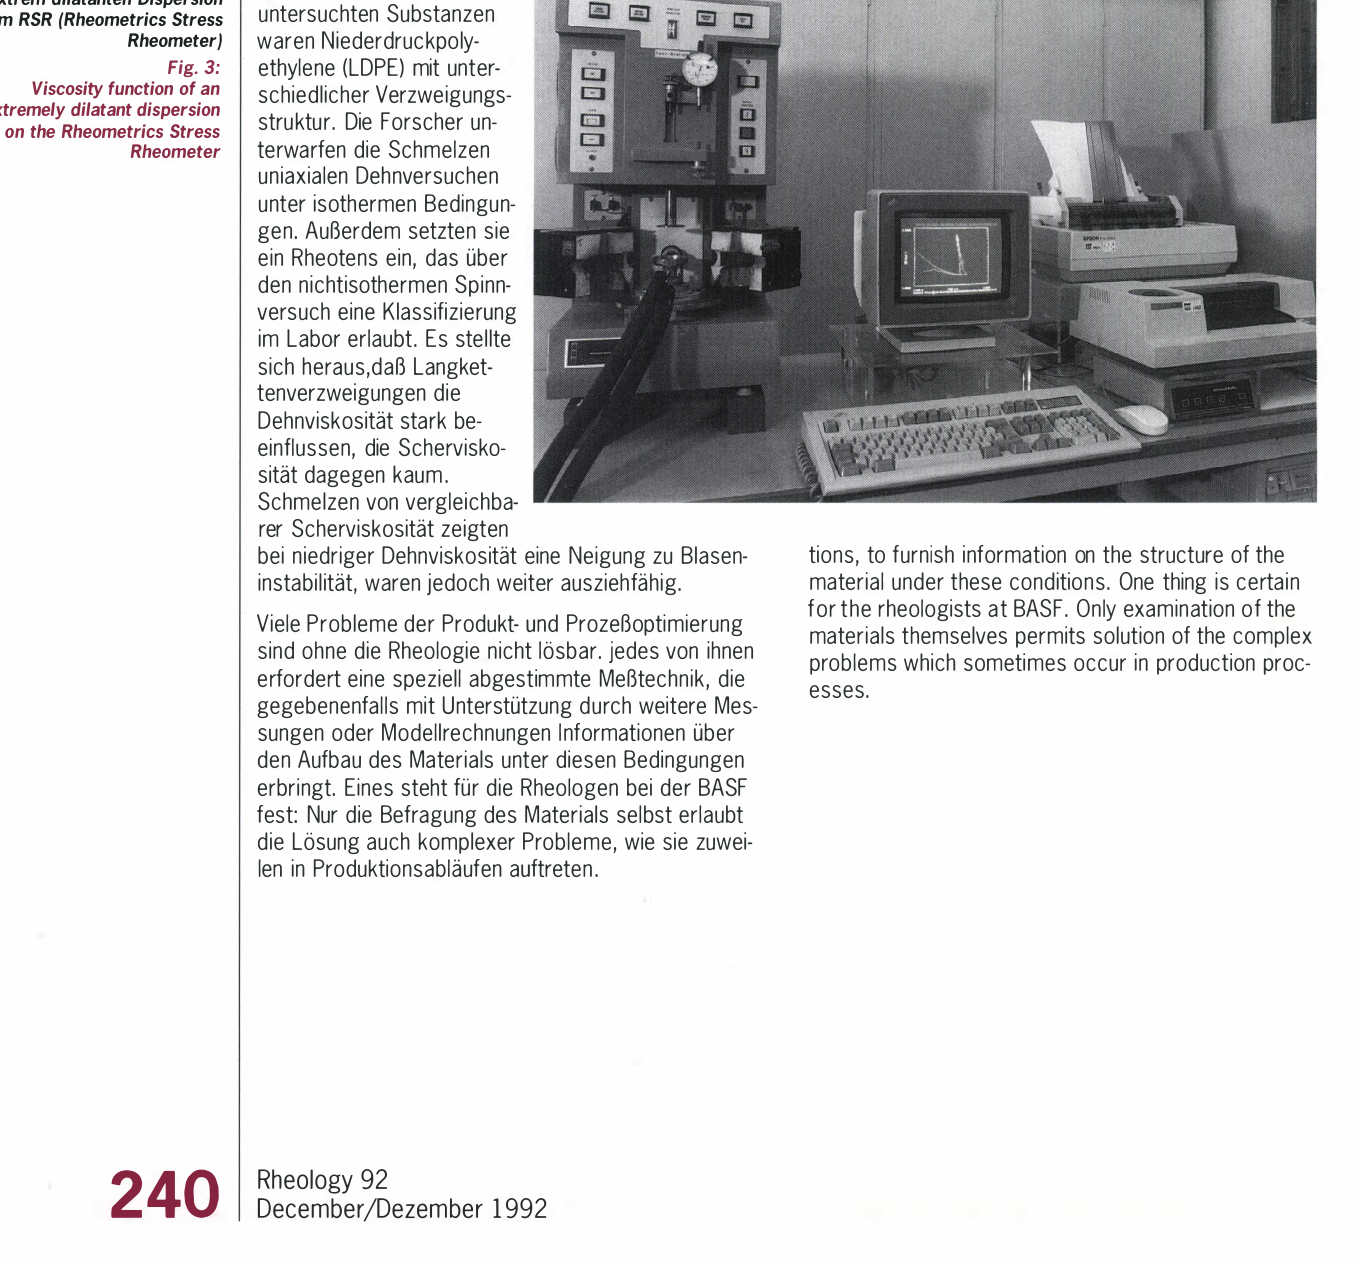
Rheometer) Fig. 3: Viscosity function of an extremely dilatant dispersion on the Rheometries Stress